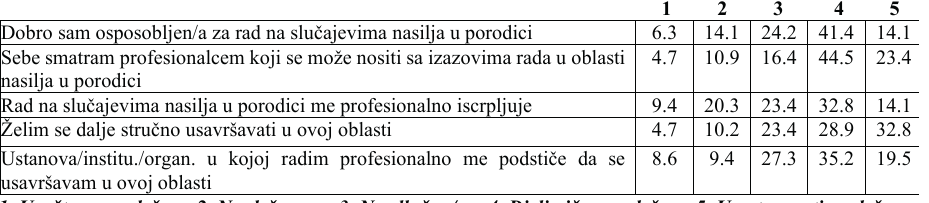
sionalnom radu u ovoj oblasti. Takva konsta- tacija može se izvući iz rezultata prikazanih u sljedećoj tabeli.